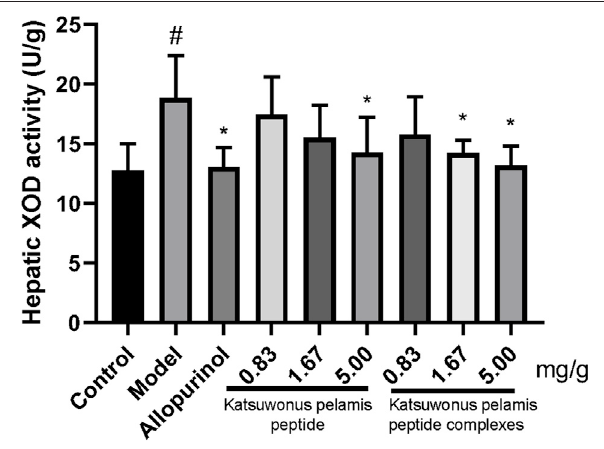
FIGURE 3 | Effects of Katsuwonus pelamis peptide and its complexes on hepatic XOD activities in hyperuricemic mice induced by potassium oxonate. # p < 0.05comparedwiththecontrolgroup;* p < 0.05comparedwith the model